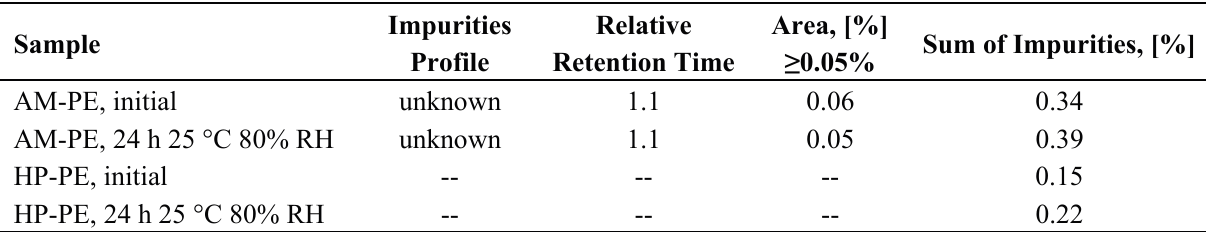
Table 3. HPLC results of the initial studies of AM-PE and HP-PE and those following hygroscopicity